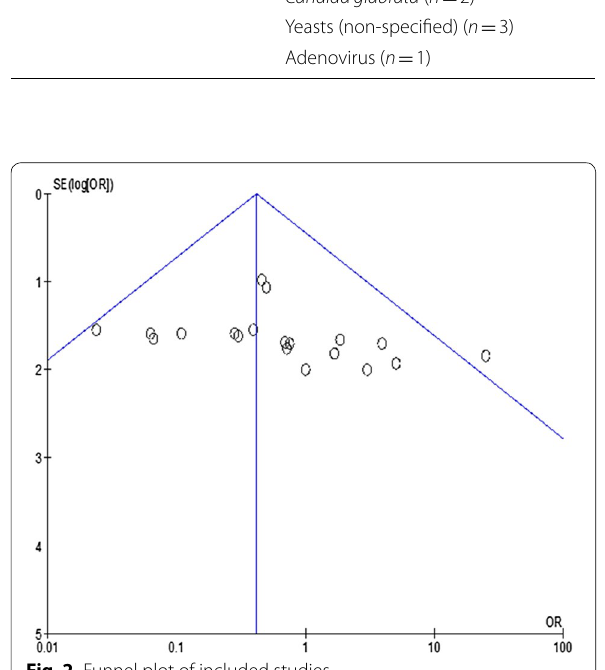
Fig. 2 Funnel plot of included